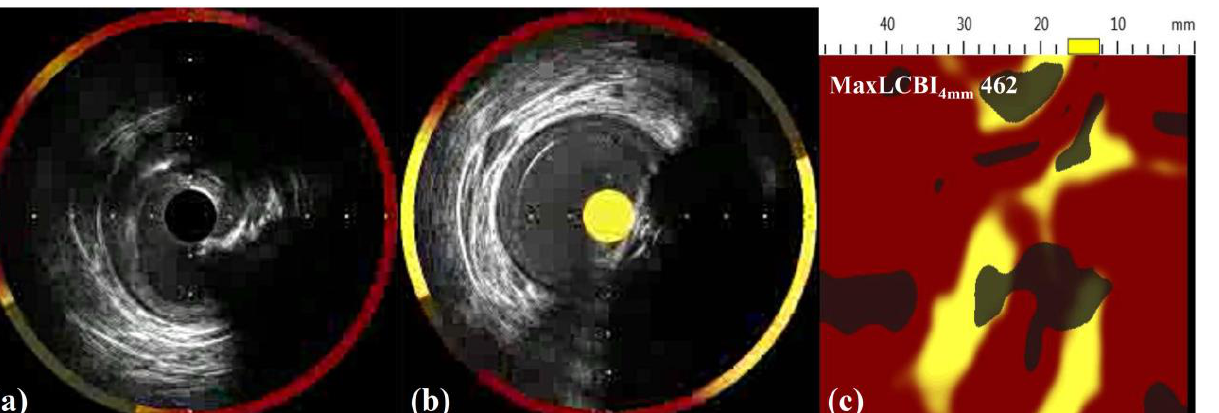
Figure 2. NIRS-IVUS images of the nonobstructive coronary artery lesion. NIRS-IVUS pullback re- vealing a calcific protrusion in the lesion area ( a ) and high lipid burden ( b ). The LCBI spread-out plot reports a MaxLCBI4mm of 462 ( c ). LCBI, lipid core burden index; MaxLCBI4mm, maximum